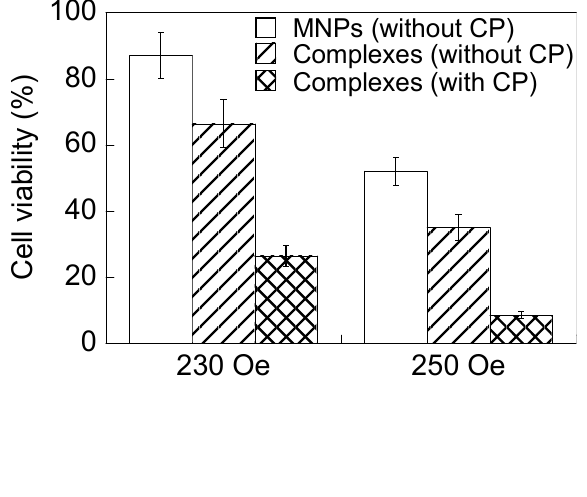
Figure 9. HeLa cell viability in the presence of PEI-coated MNPs, MNP/antibody complexes or MNP/antibody complexes and cryptotanshinone (CP) and when applying an AC magnetic field for 1 h. The magnetic field intensities were 230 and 250 Oe. The AC magnetic field frequency was 210 kHz. Cryptotanshinone effectively reduced cell